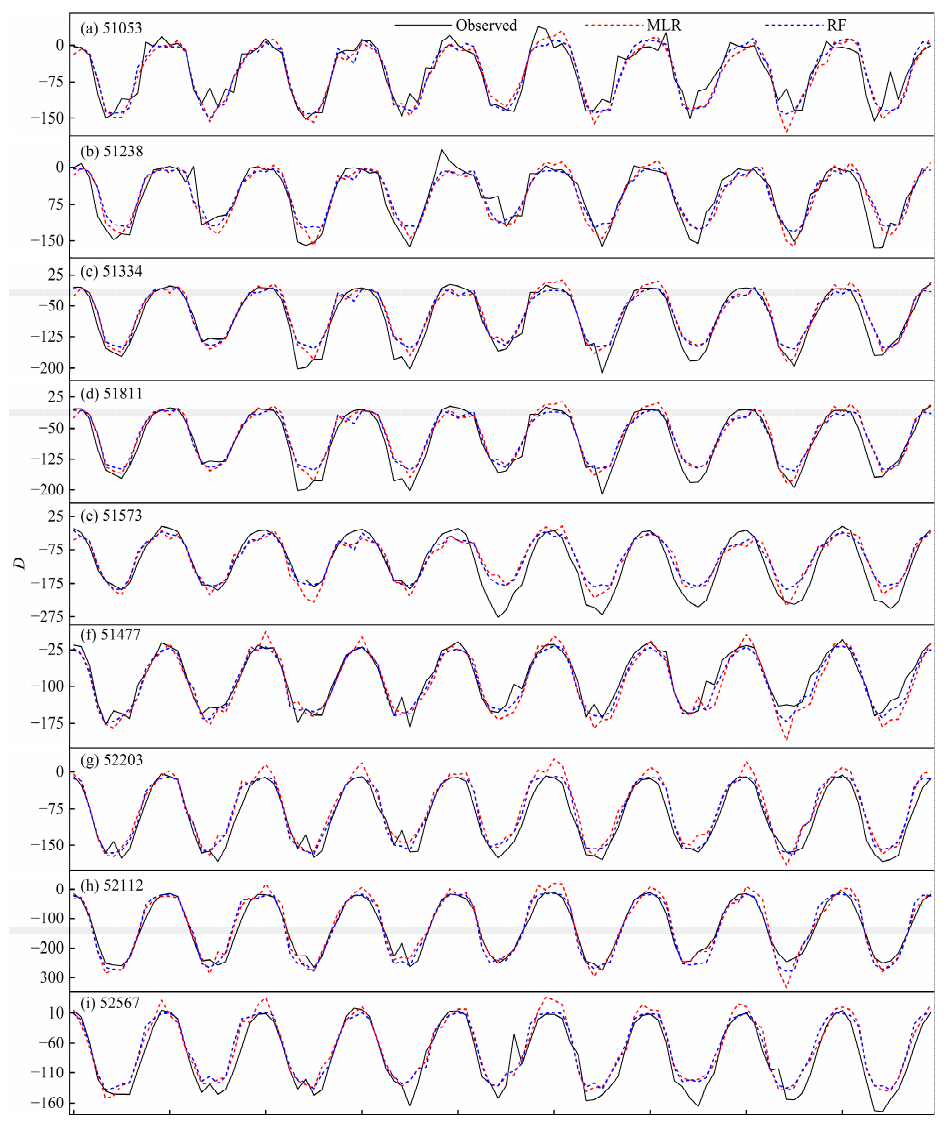
Figure 7. Comparison of the observed and MLR- and RF-simulated monthly D during the validation period at 9 representative sites in northwestern China.